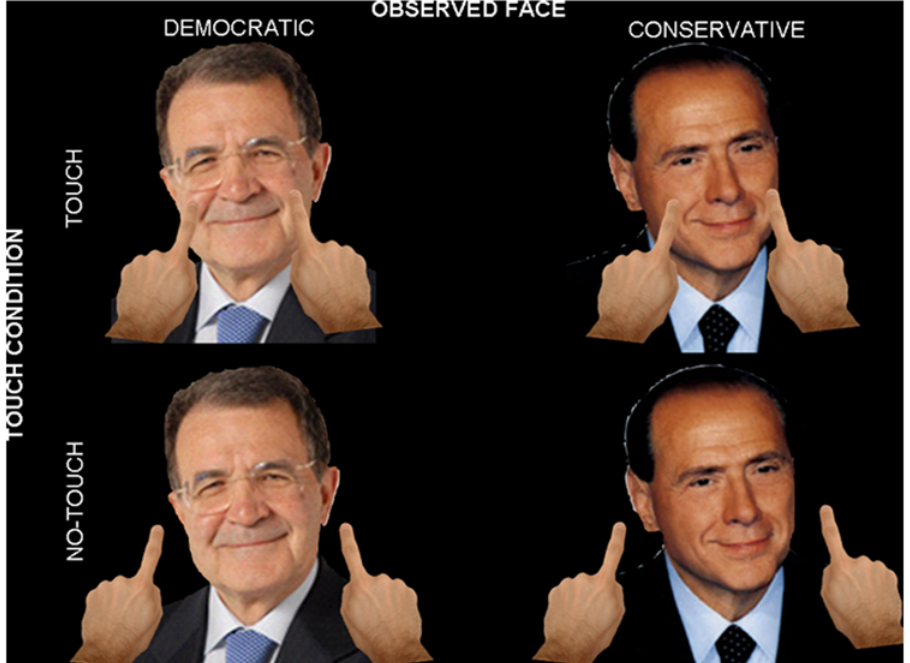
Figure 1. Experimental design. Subjects performed the tactile confrontation task in a two by two design. Over a series of trials they viewed either In-group or Out-group faces, with those groups defined by either ethnic (Experiment 1) or political (Experiment 2) similarity to the viewer. The depicted face could be touched (Touch Condition) or simply approached (No-Touch condition) by one or two fingers on either the right, left or both sides of the depicted face. Figure 1 shows examples of stimuli from Experiment 2: the face of a Democratic (on the left) and a Conservative (on the right) political leader, was either touched (on the top) or simply approached (on the bottom) by two fingers. The pictures on the left represent an In- group condition for a Democratic observer and an Out-group condition for a Conservative observer and vice-versa for the pictures on the right.